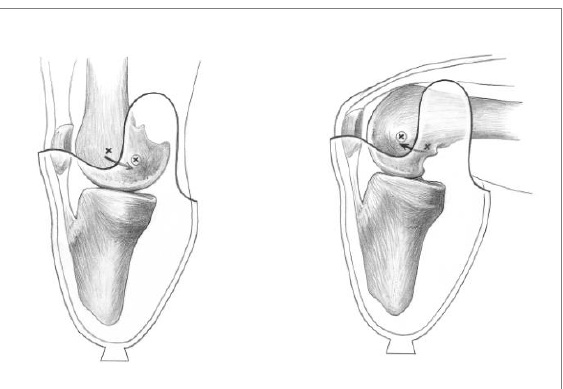
Figure 1: Illustration demonstrating femoral movement within the Söderberg socket.